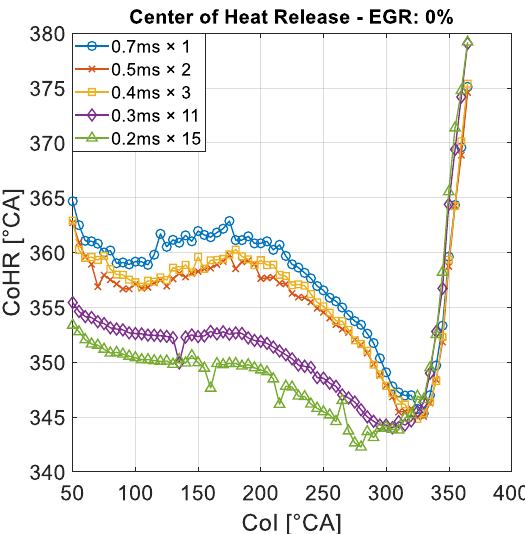
Figure 6. The center of heat release of the investigated structures with the same dose in the function of CoI without EGR.